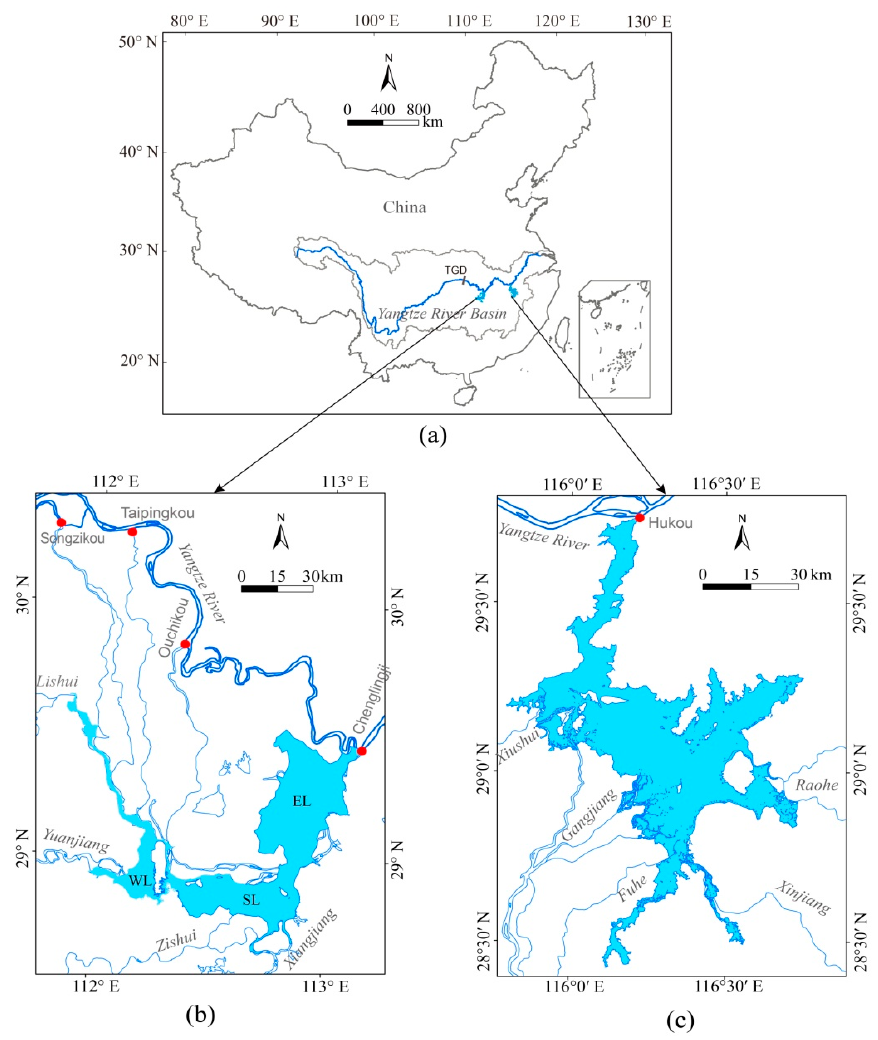
Figure 1. Geographical location of the study area: ( a ) China and the Yangtze River Basin; ( b ) Dongting Lake; and ( c ) Poyang Lake.